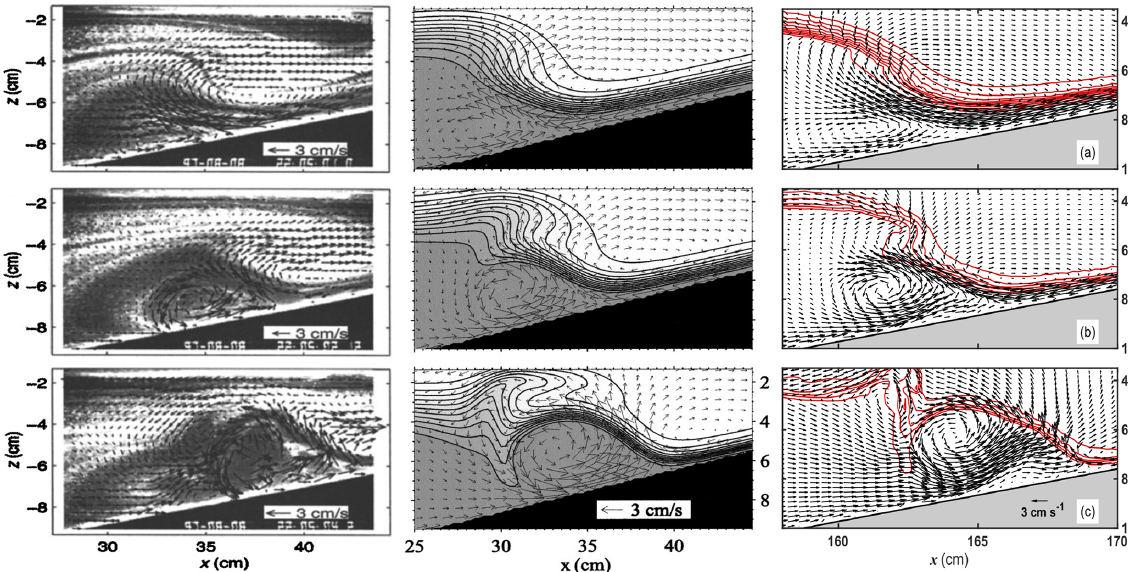
Figure 16. Comparison of velocity fields during the wave breaking on a linear slope between (left) the PIV observations in the laboratory (Michallet and Ivey, 1999), (middle) the numerical model simulation (Bourgault and Kelley, 2004), and (right) ORCTM simulation at t = (a) 21.7, (b) 22.2, and (c) 23.2s from top to bottom. The red contours indicate the isopycnic